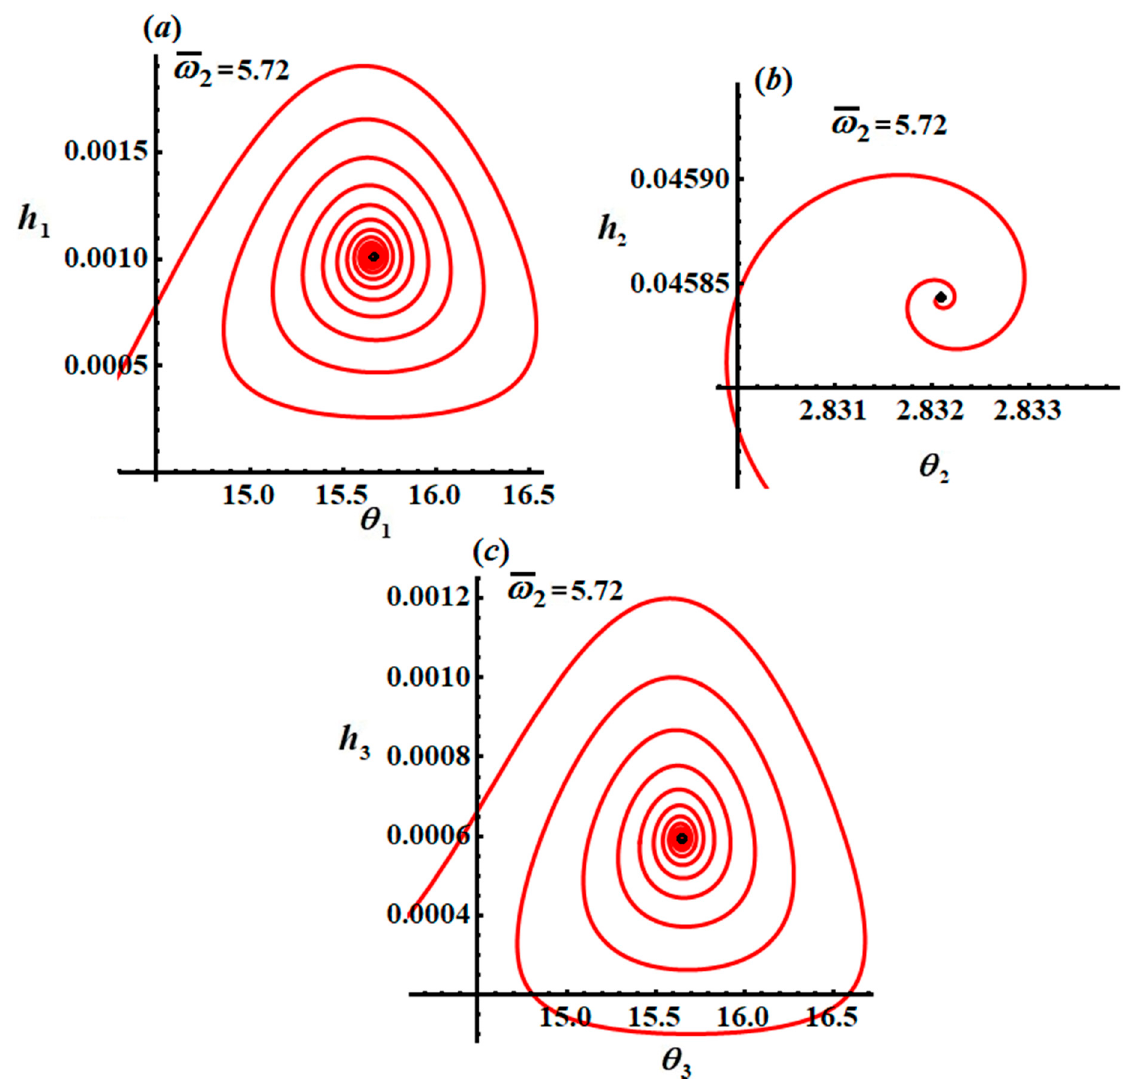
Figure 9. The amplitude modulation of h